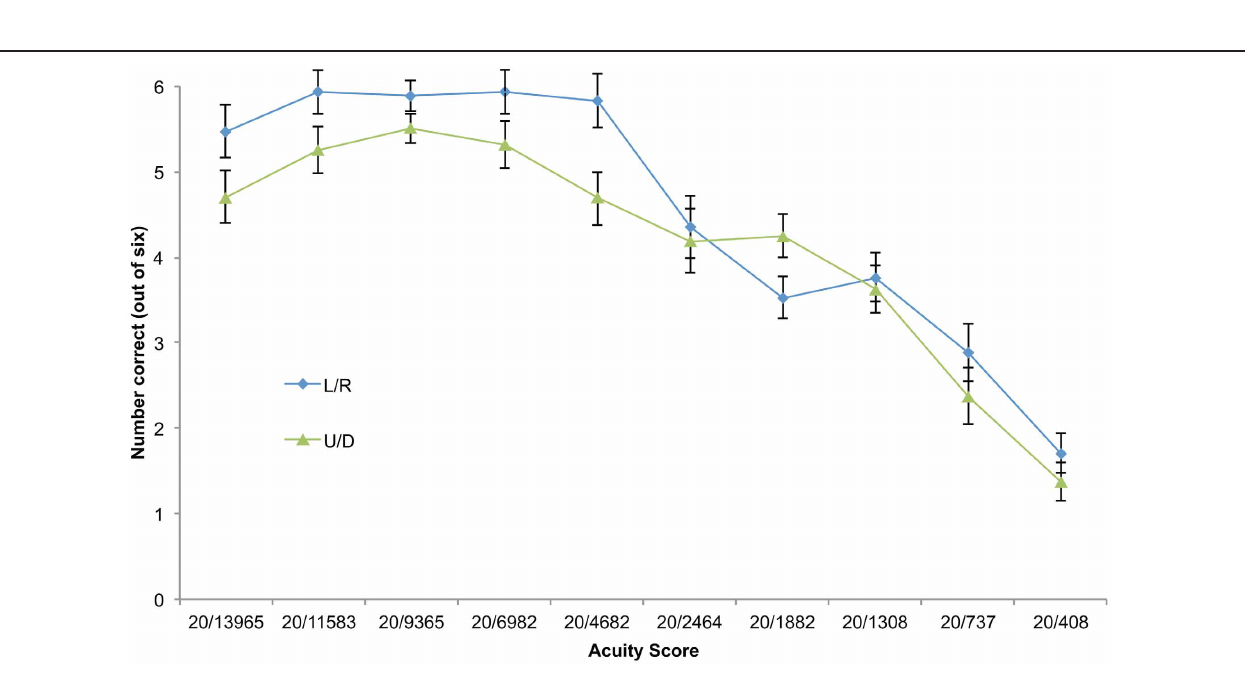
20/1882 performance was superior on up/down oriented opto-types ( Figure 7 ), however the interaction effect was not significant.